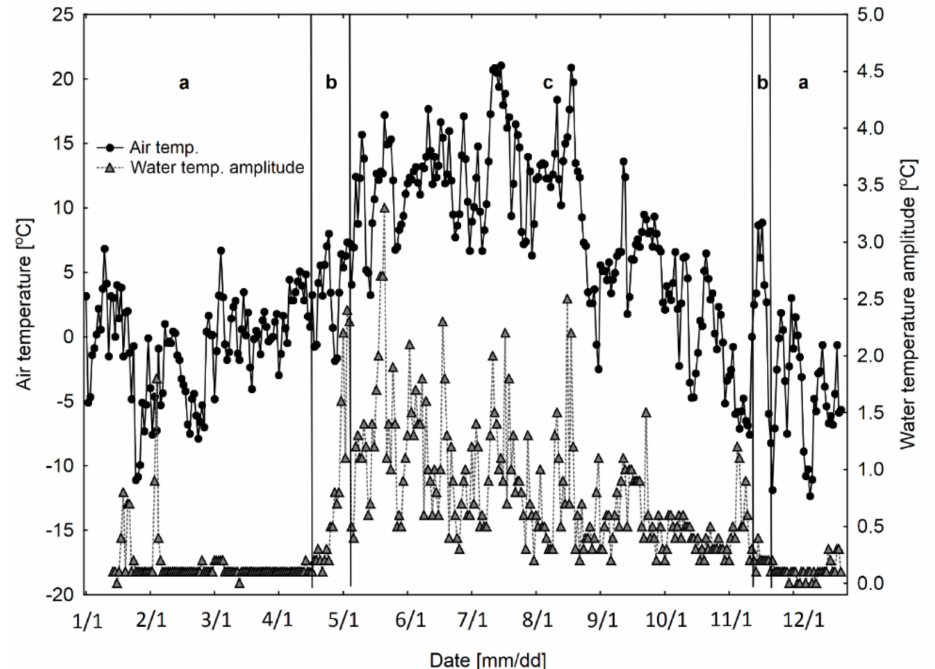
Figure 12. Changes in mean daily air temperatures and water temperature amplitudes in time at a depth of 1 m. a—presence of ice cover; b—occurrence of ice phenomena; c—lack of ice cover/ice phenomena.